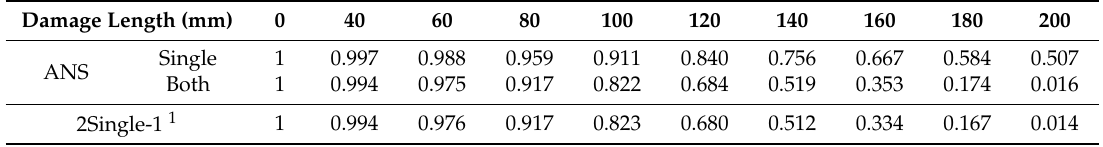
The right part of Equation (4) 2 NK S ( l ) − 1 is calculated and listed in the last row of Table 3 and is also plotted in Figure 29 labelled by 2Single-1. It can be seen that the 2 NK S ( l ) − 1 is almost identical with NK B ( l )